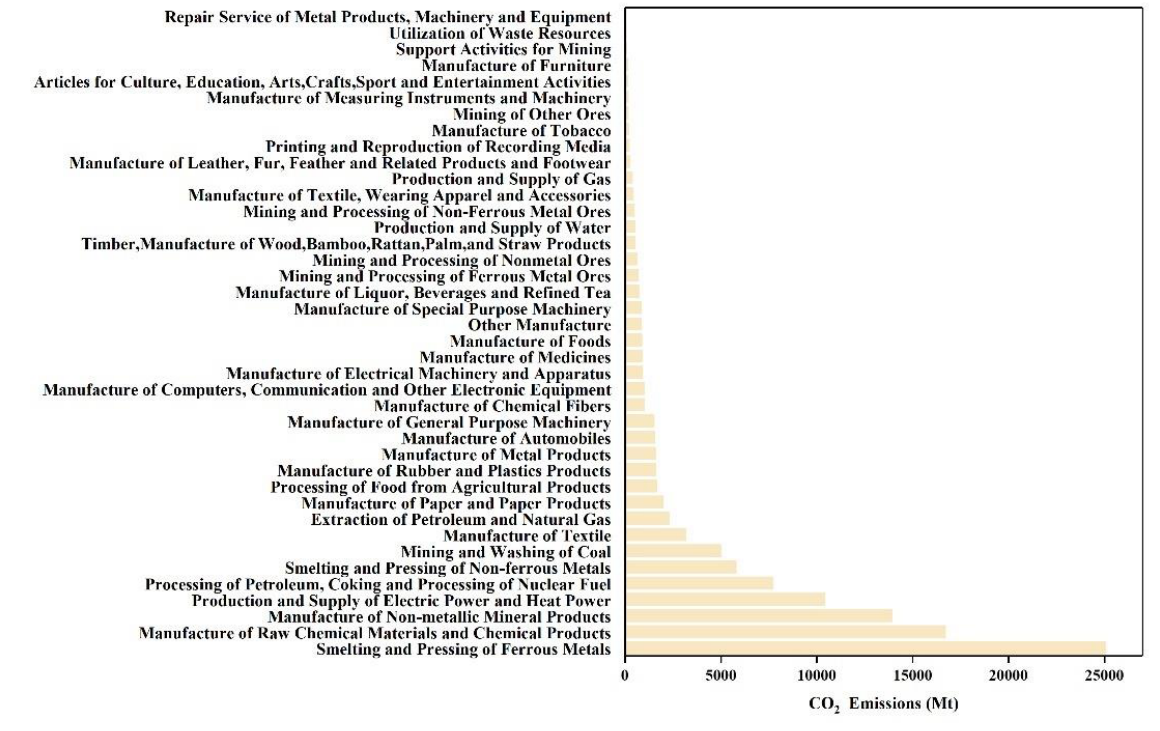
Figure 4. CO 2 emissions from industrial sub-sectors during 1995–2019.